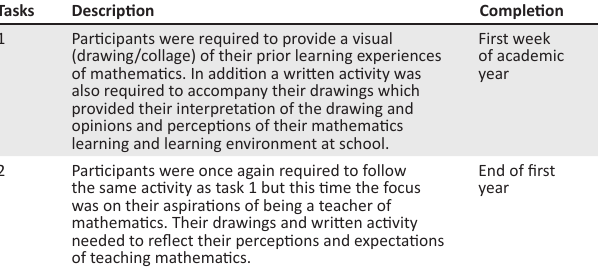
TABLE 1: Task instructions to illustrate participants’ perceptions and experiences of learning and teaching mathematics. Tasks